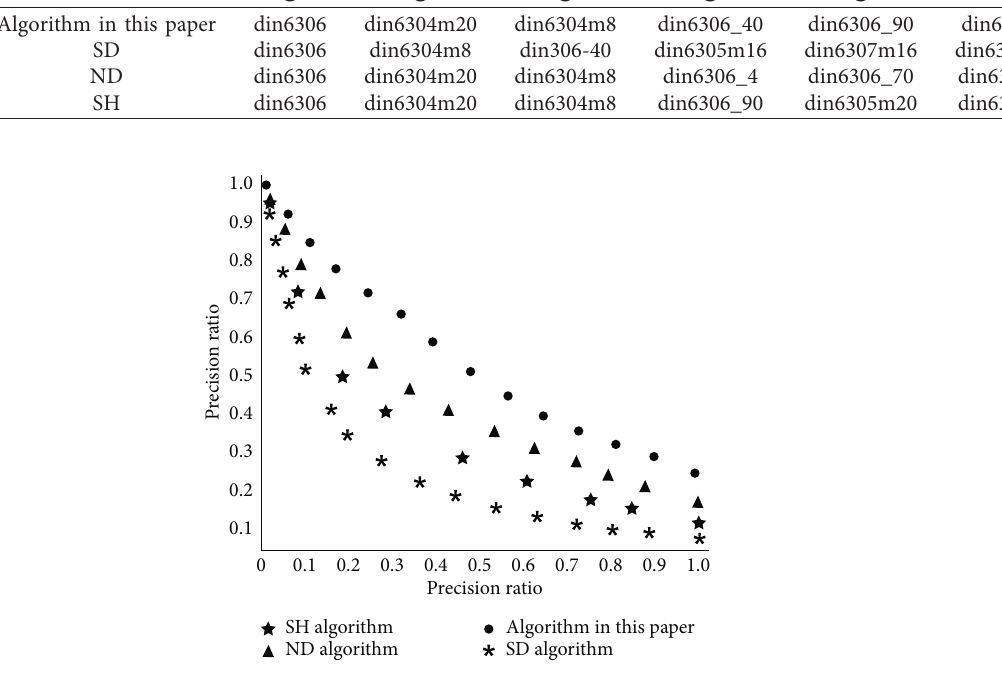
Figure 8: Comparison of average recall-precision ratio curves of the four retrieval algorithms. Table 2: Comparison of E-measurement indicators of the four retrieval